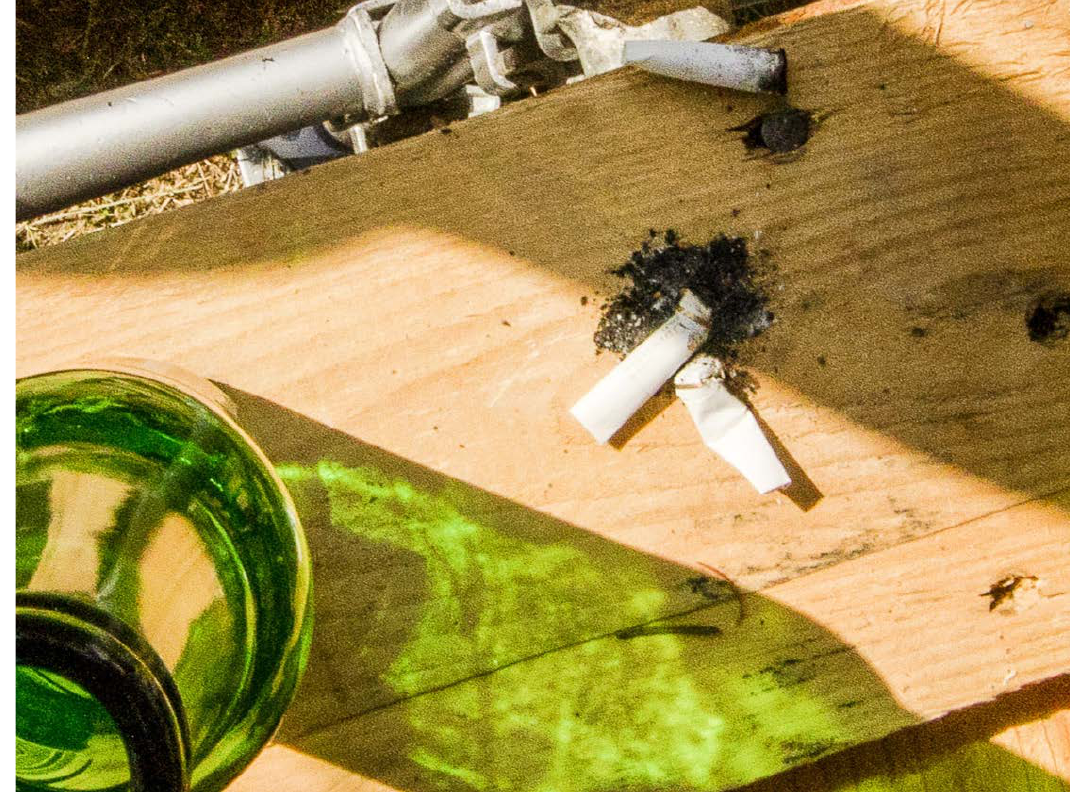
Figure 14: Empty bottles and